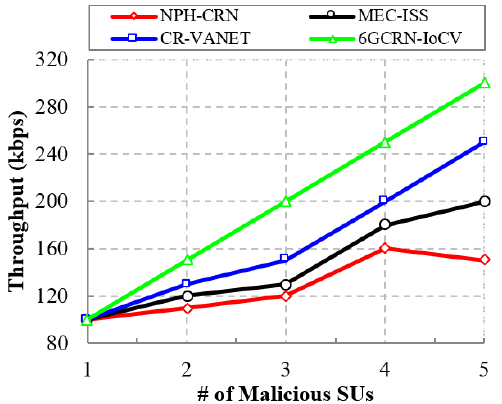
Figure 8. Throughput vs. the number of malicious SUs.